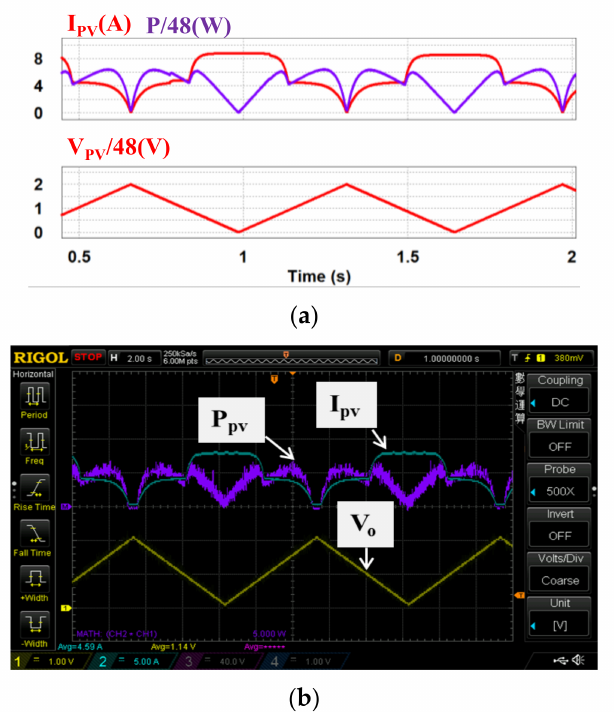
Figure 14. Output results of the proposed PV emulator under S = 500 & 1000 with theoretical PV values: ( a ) simulated power and current outputs and PV voltage; ( b ) implemented power and current outputs and PV voltage.